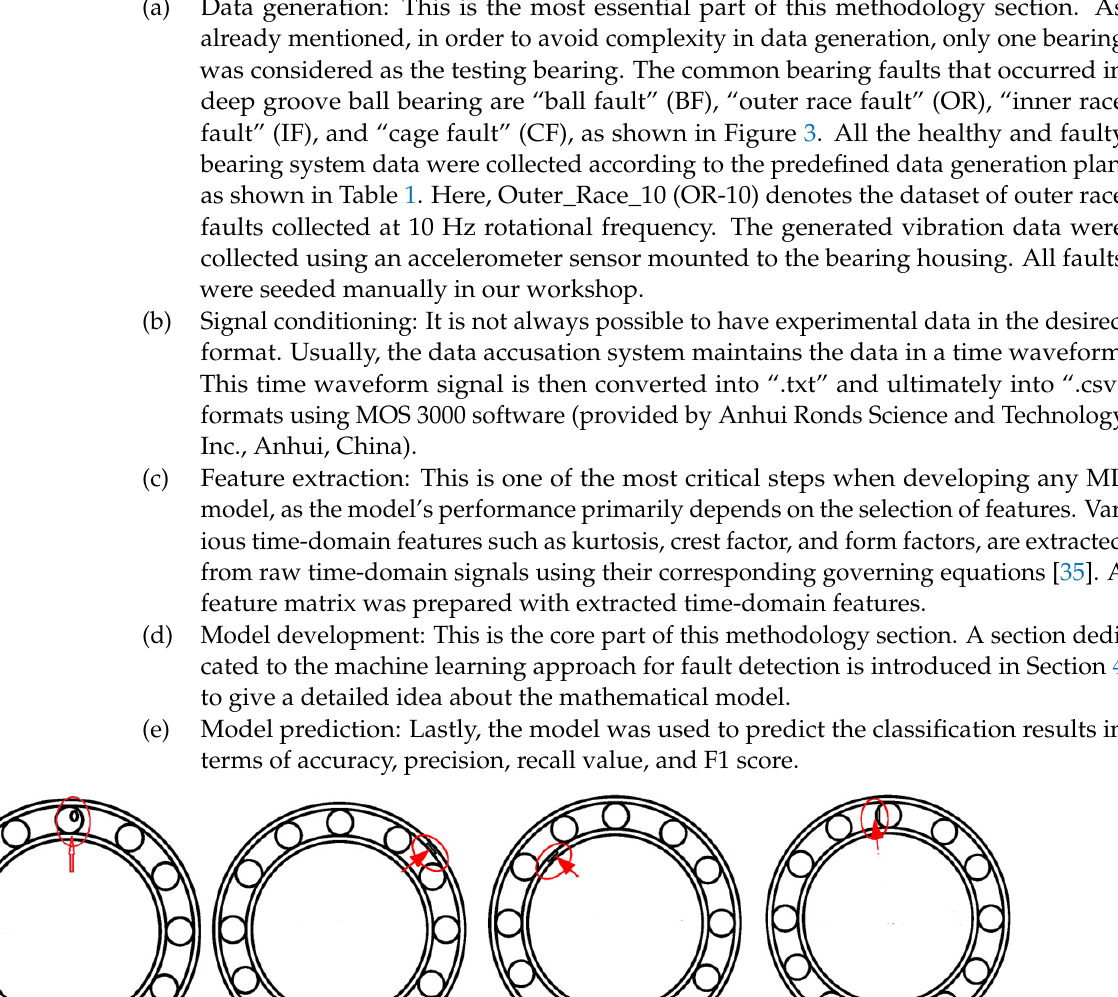
Figure 2. Step-by-step approach from data generation to fault diagnosis.